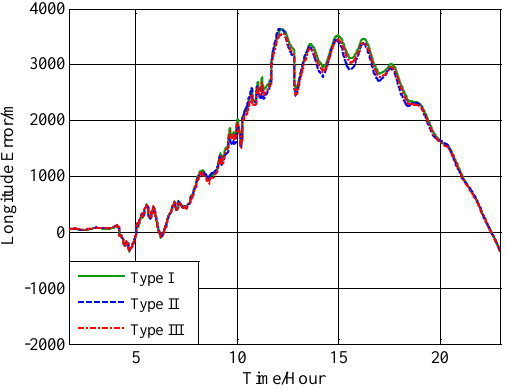
Figure 17. The comparison of the longitude error.